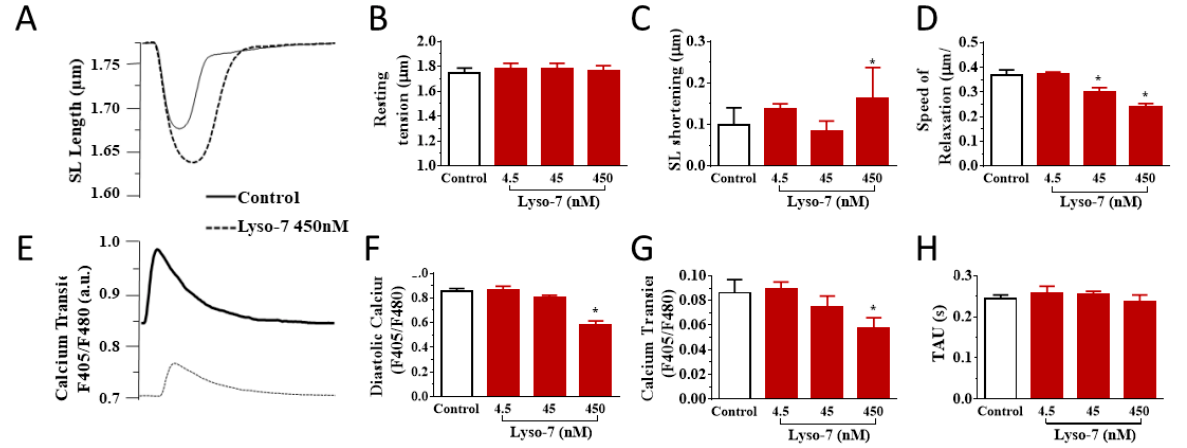
Figure 5. Acute effect of Lyso-7 on contraction ( A – D ) and Ca 2+ transient ( E – H ) in cardiomyocytes of untreated mice. Typical recordings of Lyso-7 (450 nM) effects on sarcomere length (SL) shortening ( A ) and Ca 2+ transient ( E ), both under field stimulation at 1 Hz. ( B – D ) averaged data of resting SL, SL shortening and relaxation, respectively, and ( F – H ): averaged data of diastolic Ca 2+ , Ca 2+ transient and decay of Ca 2+ transient (Tau), respectively, for Control, and increasing concentration of Lyso-7 (4.5, 45, and 450 nM). ANOVA followed by Tukey post-test ( p < 0.05). * Lyso-7 vs. Control. Control refers to the absence of Lyso-7. n = 12–18.